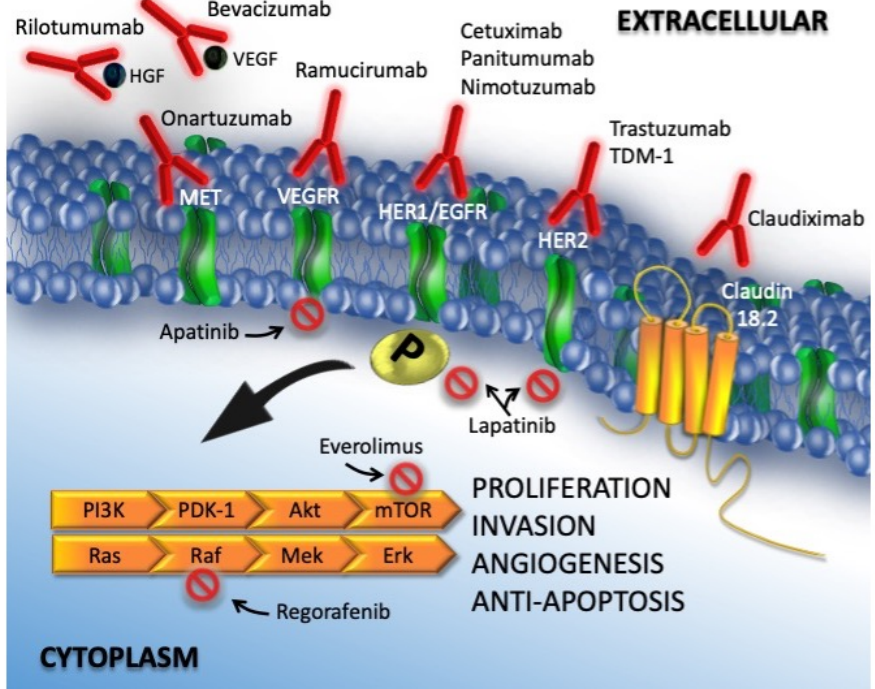
Figure 1. Targeted therapy and oncogenic pathways in gastric cancer. Activation of ERK-AMP KI- NASE : ligand binding to a growth factor receptor activates the small GTP-binding RAS protein, which interacts with RAF protein kinase. RAF phosphorylates and activates MEK (MAP kinase or ERK kinase), which then activates ERK (extracellular signal-regulated kinase) by phosphorylation of tyrosine and threonine residues. Activated ERK translocates into the nucleus where it phosphor- ylates the Elk-1 transcription. PI3K/AKT/MTOR Pathwa y: PI3K/AKT/MTOR signaling constitutes an important pathway that consists of two steps: phosphatidylinositol 3-kinase (PI3K) and its down- stream molecule serine/threonine protein kinase B (PKB; also known as AKT). The PI3/AKT/mTOR pathway is stimulated by RTK and cytokine receptor activation. Tyrosine residues are then phos- phorylated and provide anchor sites for PI3K translocation to the membrane, thus participating in the transduction of various extracellular matrix molecules and cytokines, including mTOR, a ser- ine/threonine protein kinase and a member of the PI3K-associated kinase protein family.